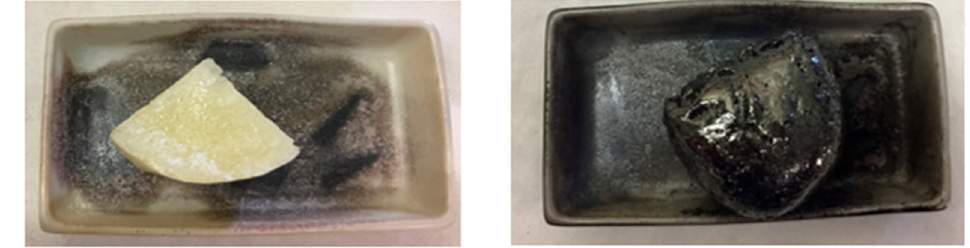
Figure 6. Portion of β NS before and after the pyrolysis .